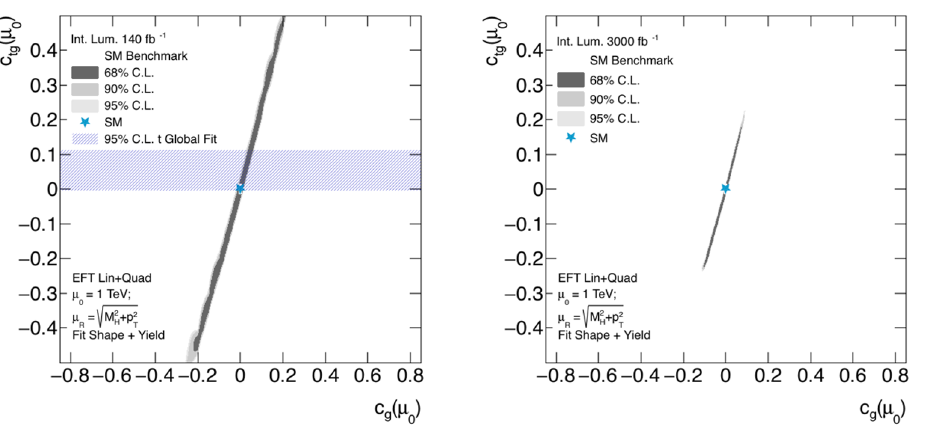
Figure 10. Constraints on the c g and c tg coefficients at 68% (dark grey), 90% (mid grey) and 95% (light grey) C.L. obtained from the fit to the spectrum shape and Higgs signal rate on 200 < p H 2000 GeV with 140 fb − 1 (left panel) and 3000 fb − 1 (right panel) for µ 0 = 1 TeV. The SM value is indicated by the blue star and the best fit value by the white marker. The shaded horizontal strip indicates the 95% C.L. interval for c tg from the top quark fit of ref. [71] translated to our definition of c tg ( µ 0 )